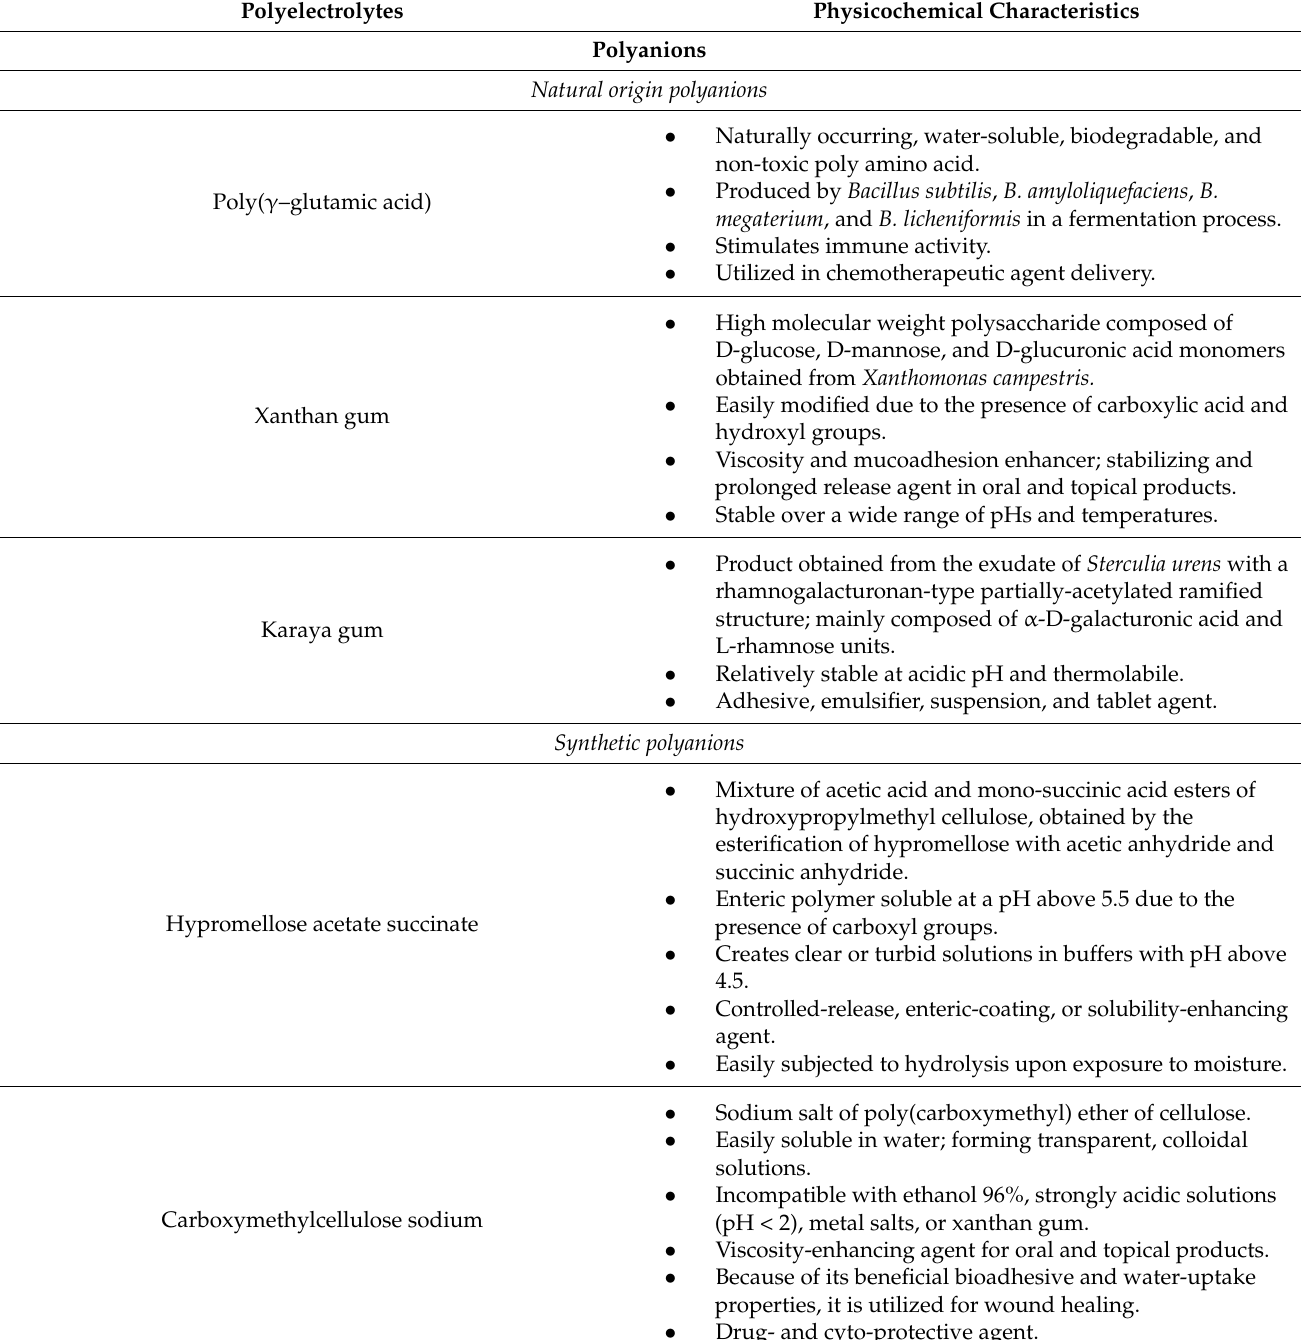
Table 1. Cont. Polyelectrolytes Physicochemical Characteristics